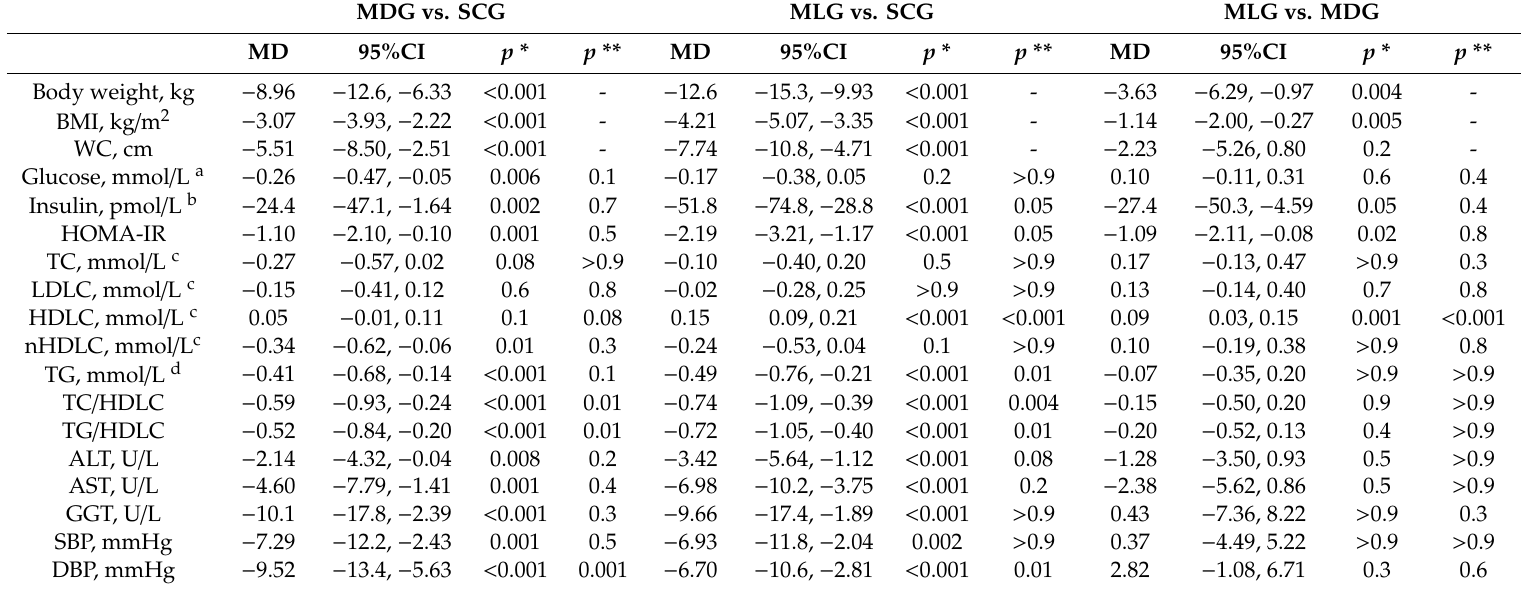
Table 2. Between-group di ff erences in cardiometabolic markers according to intention to treat analysis ( n =